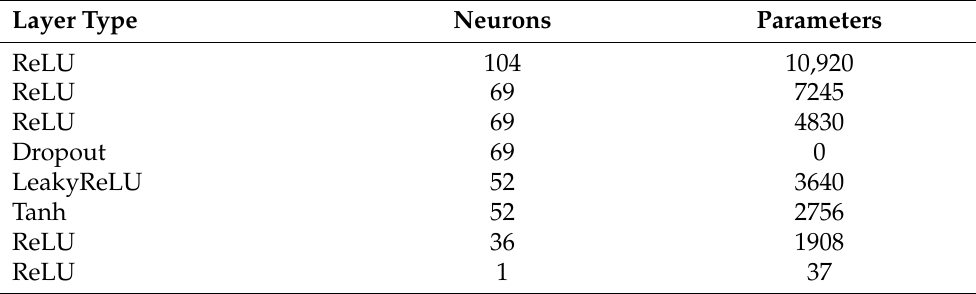
Table 1. This ANN is used to predict directly the generated power. The chosen architecture with look_back = 12, q_weight = 1.55 and quantile = 0.55. The ANN has a total of 31.336 parameters. It takes into account the wind speed, wind direction, temperature and pressure. It uses a Tanh activation in one layer as an attempt to mimic the nonlinear behavior of the power